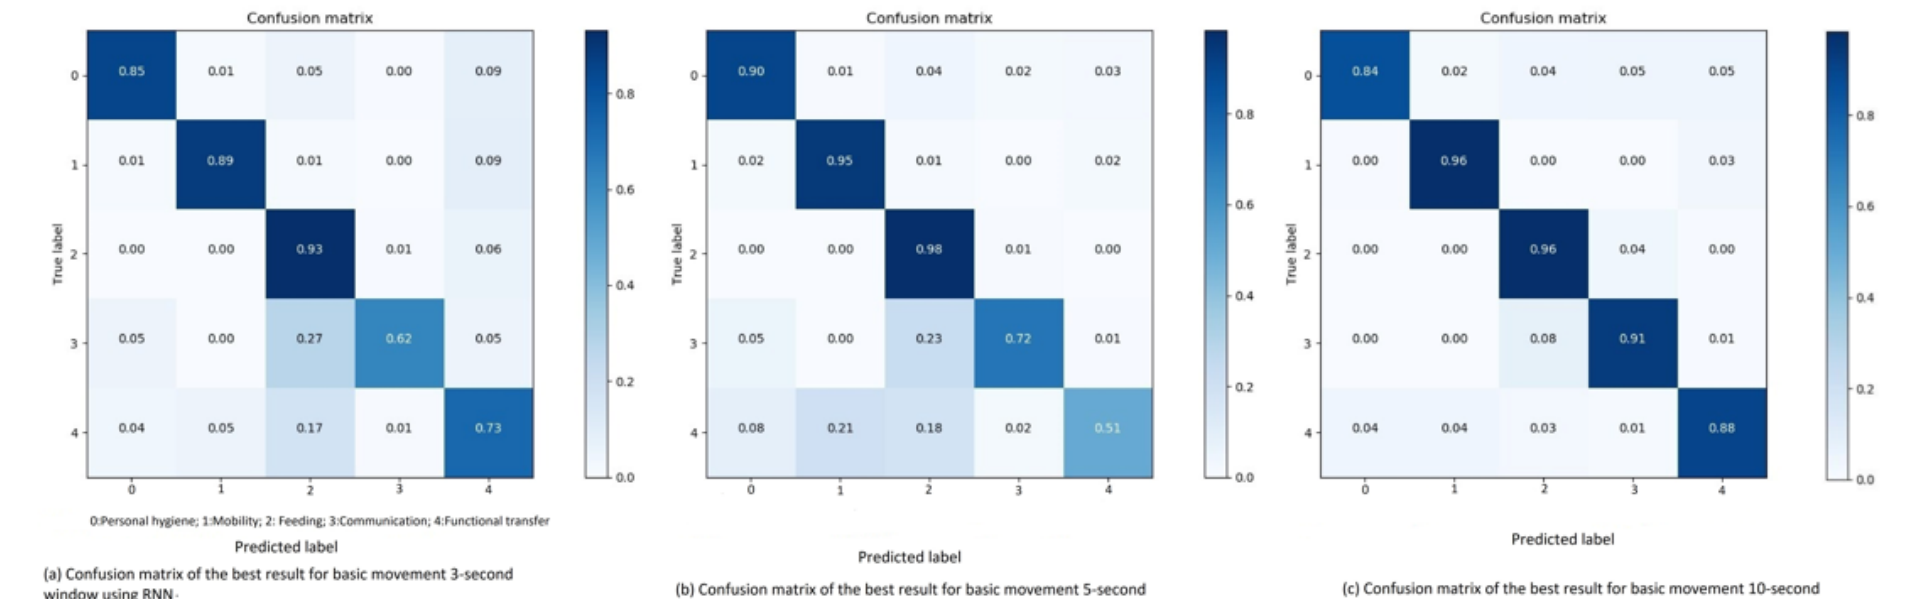
Figure 9. Confusion matrix of the best result for basic movement 3, 5, 10-s window using